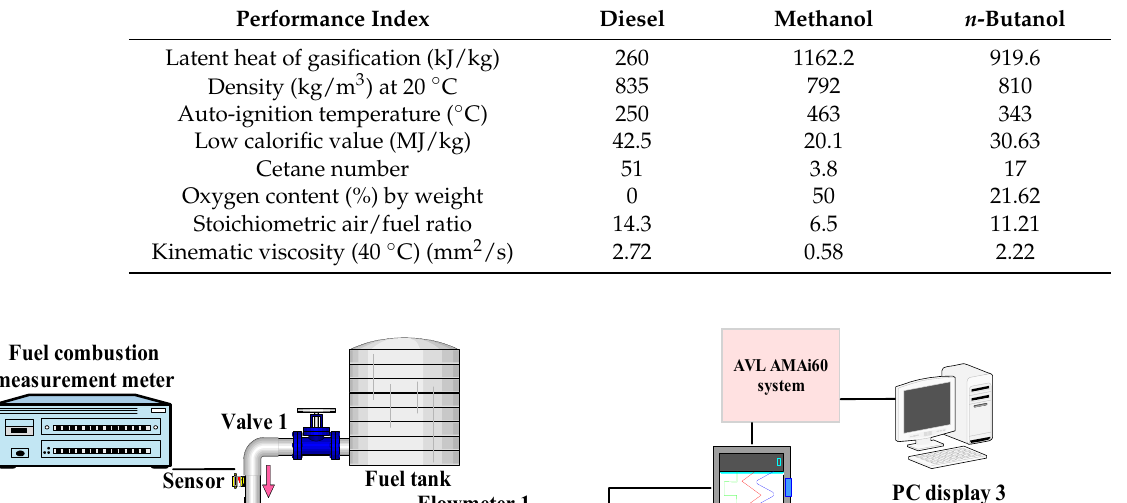
Table 2. Fuel physical properties.